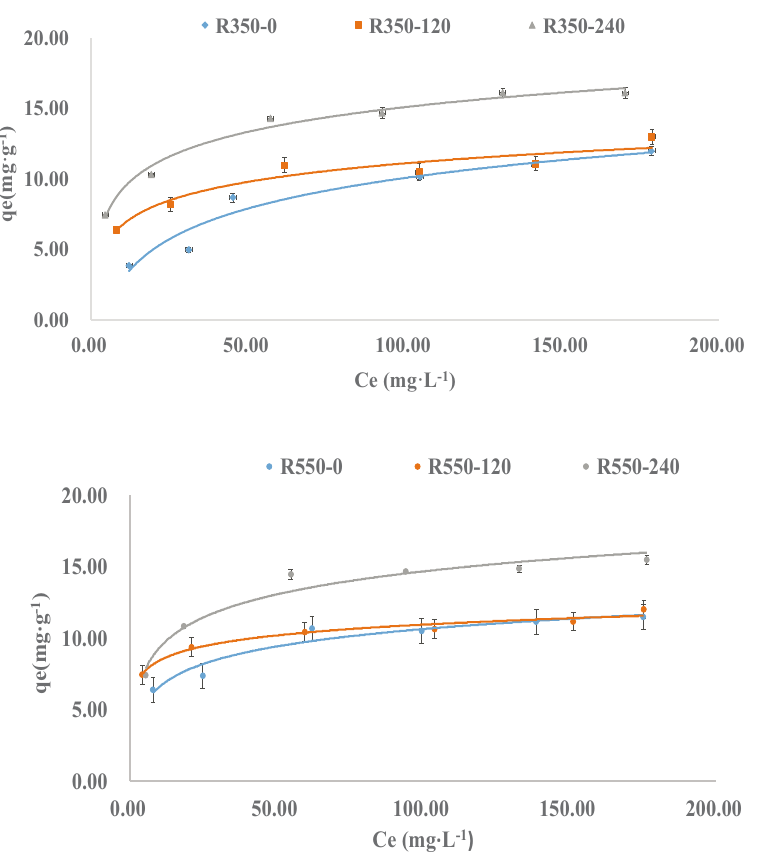
Figure 5: Cu ( II ) adsorption isotherms of rice husk biochars after di ff erent aging time in the